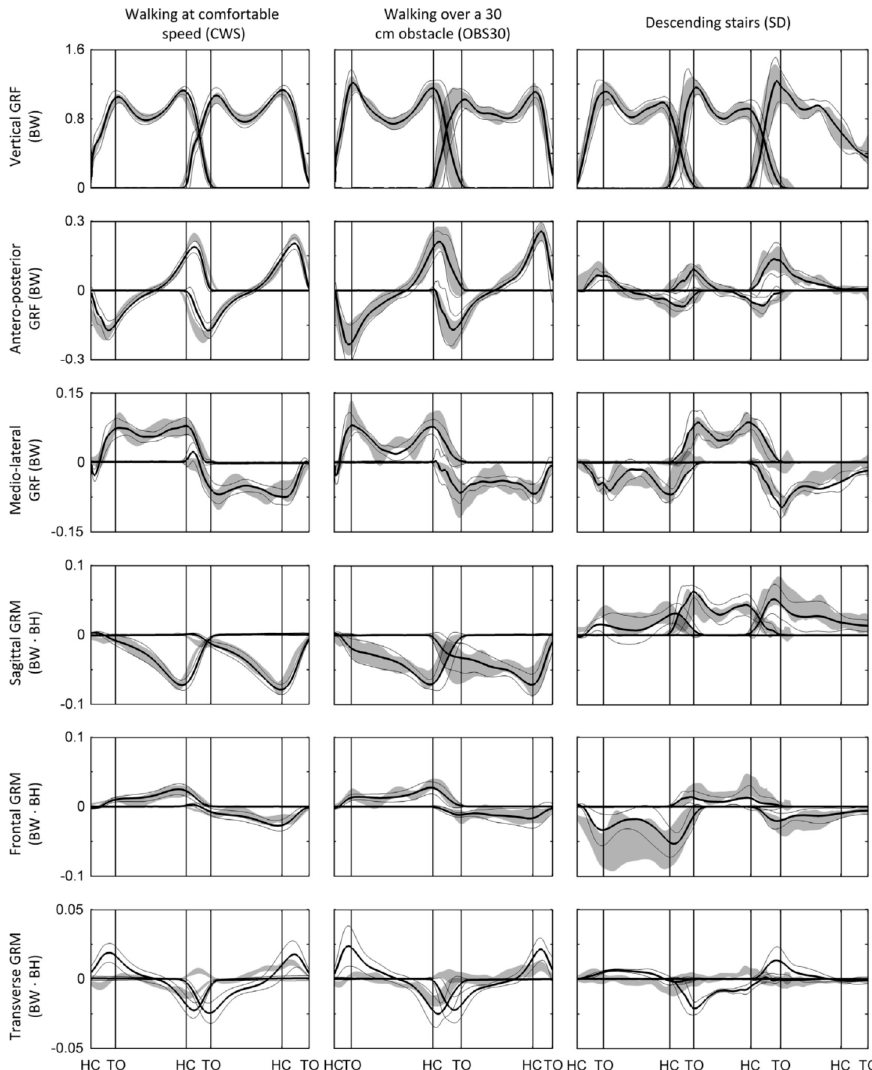
Figure 8. The calculated GRF&Ms normalized to body weight (BW) and height (BH) ± 1 standard deviation (SD) around mean (shaded area) compared with the forceplate data (mean (thick line) ± 1 SD (thin lines)). HC: heel contact; TO: toe-off (after [55]). Yang and Mao [58] proposed a seven segment lower-limb model with symmetrical legs to calculate the joint forces and (cid:1833)(cid:1844)(cid:1832)((cid:1872)) signals in the sagittal plane. Motion of the lower limbs was measured using six two-axis gyroscopes attached to the thighs, shanks and feet and two three-axis